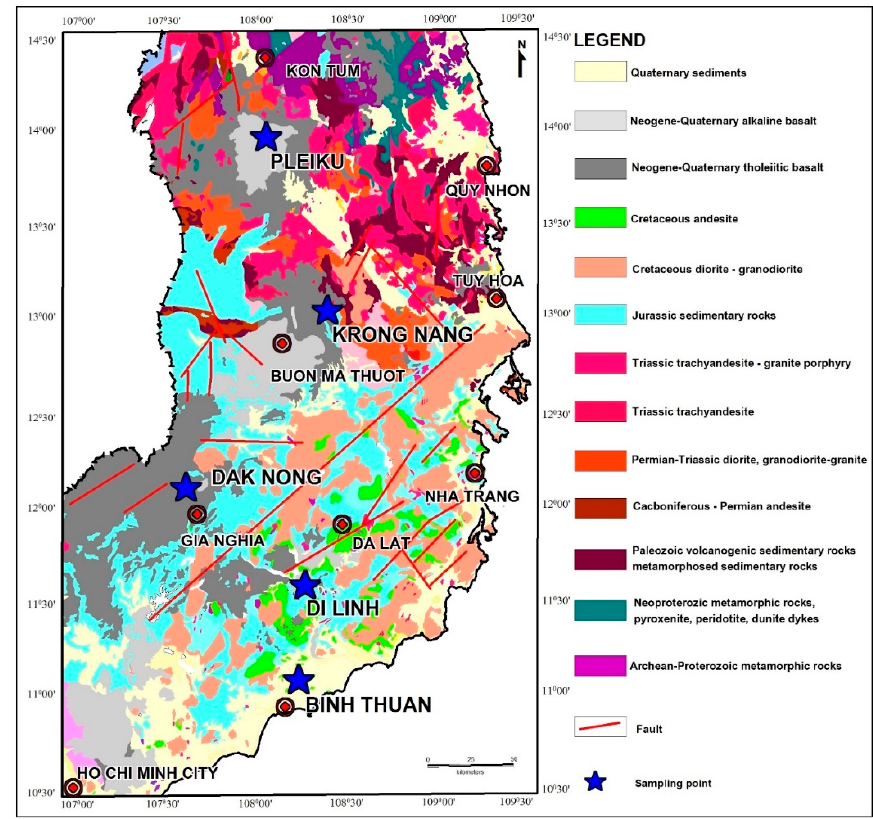
Figure 2. Geological map showing alluvial sapphire deposits and associated Cenozoic basalts underlain by the older rock formations in Southern Vietnam, modified after Hoa et al. [12].